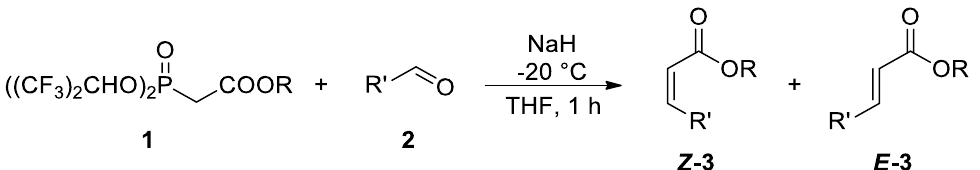
Scheme 3. Reaction of reagents 1 with various aldehydes 2 under optimized conditions. Table 3. Reactions of 1a and 1b with aldehydes 2a – 2m [a] .